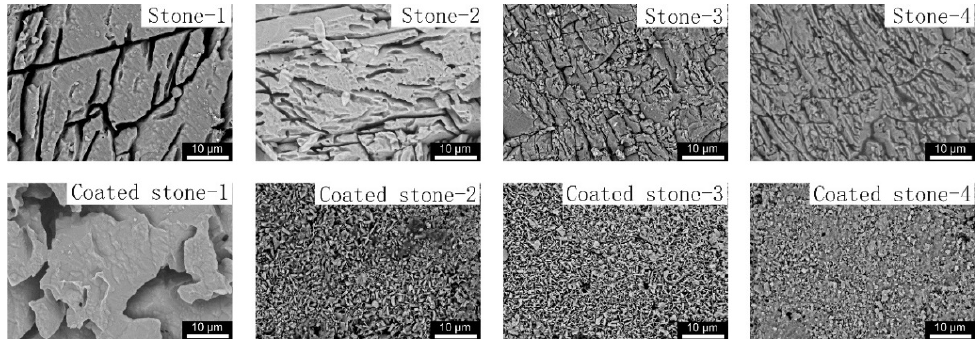
Figure 5. SEM microscope of test samples after treatment with simulated acid rain at different pH values. pH values.